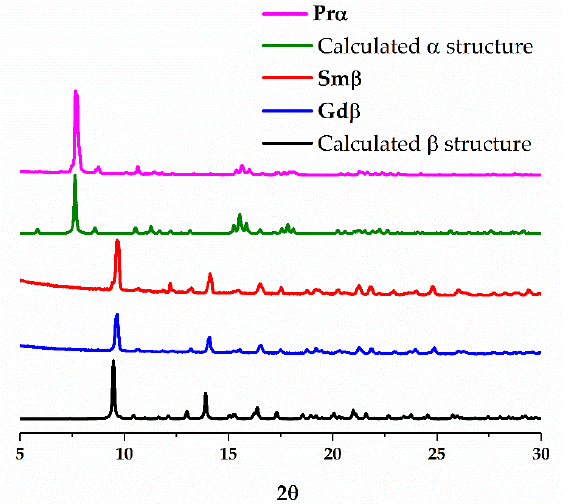
Figure 2. Calculated powder X-ray diffractograms for the 2D structures simulated from the single crystal data of Pr α ( α structure, green) and Sm β ( β structure, black). Experimental powder X-ray diffraction pattern obtained for a bulk sample of Pr α (pink), Sm β (red) and Gd β (blue). The direct mixing of the reagents, K 3 [Ru 2 (CO 3 ) 4 ]·4H 2 O in water and Ln(NO 3 ) 3 ·xH 2 O in DMSO,